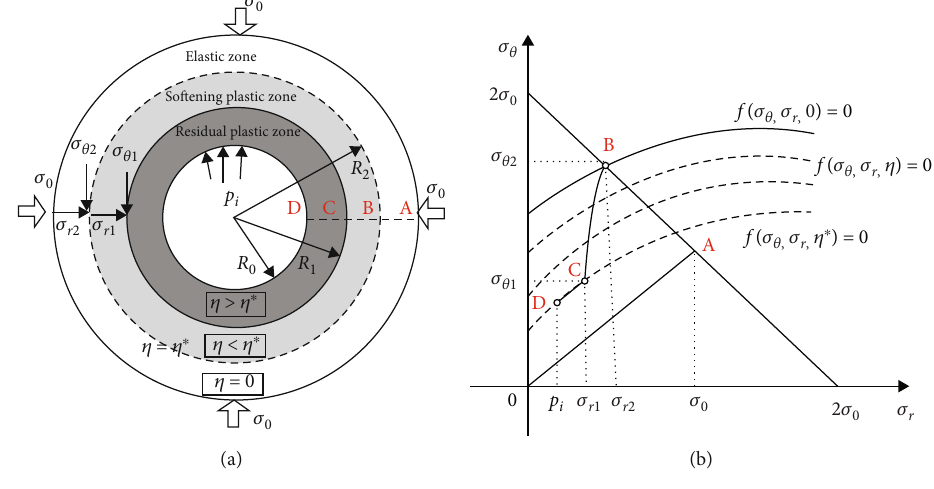
Figure 5: Variation path of the stress state modi fi ed